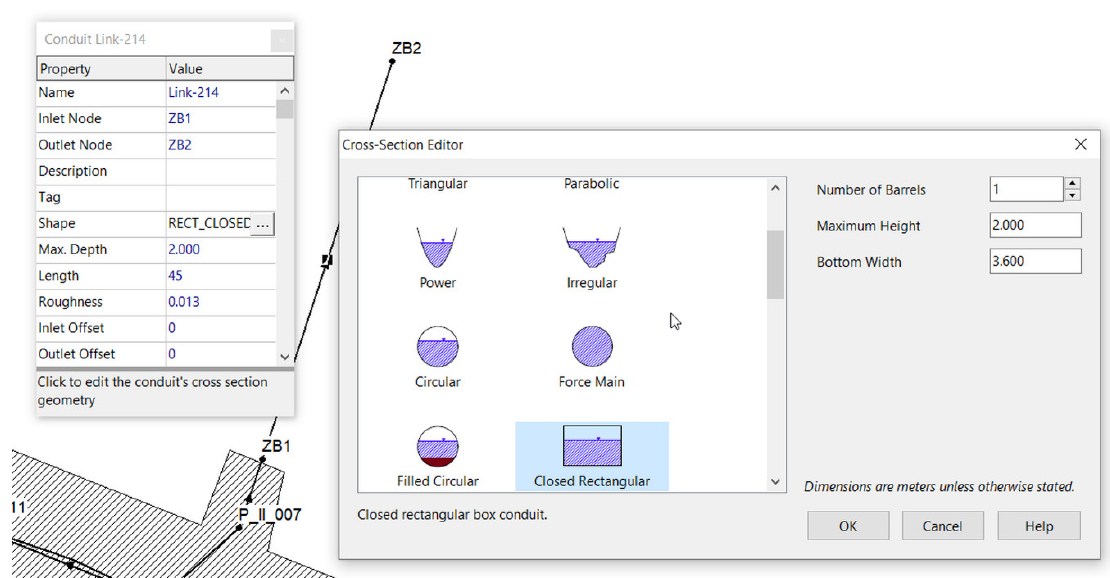
Figure 5. Representation of the underground retention tank in the Storm Water Management Model (SWMM) software by U.S. Environmental Protection Agency.